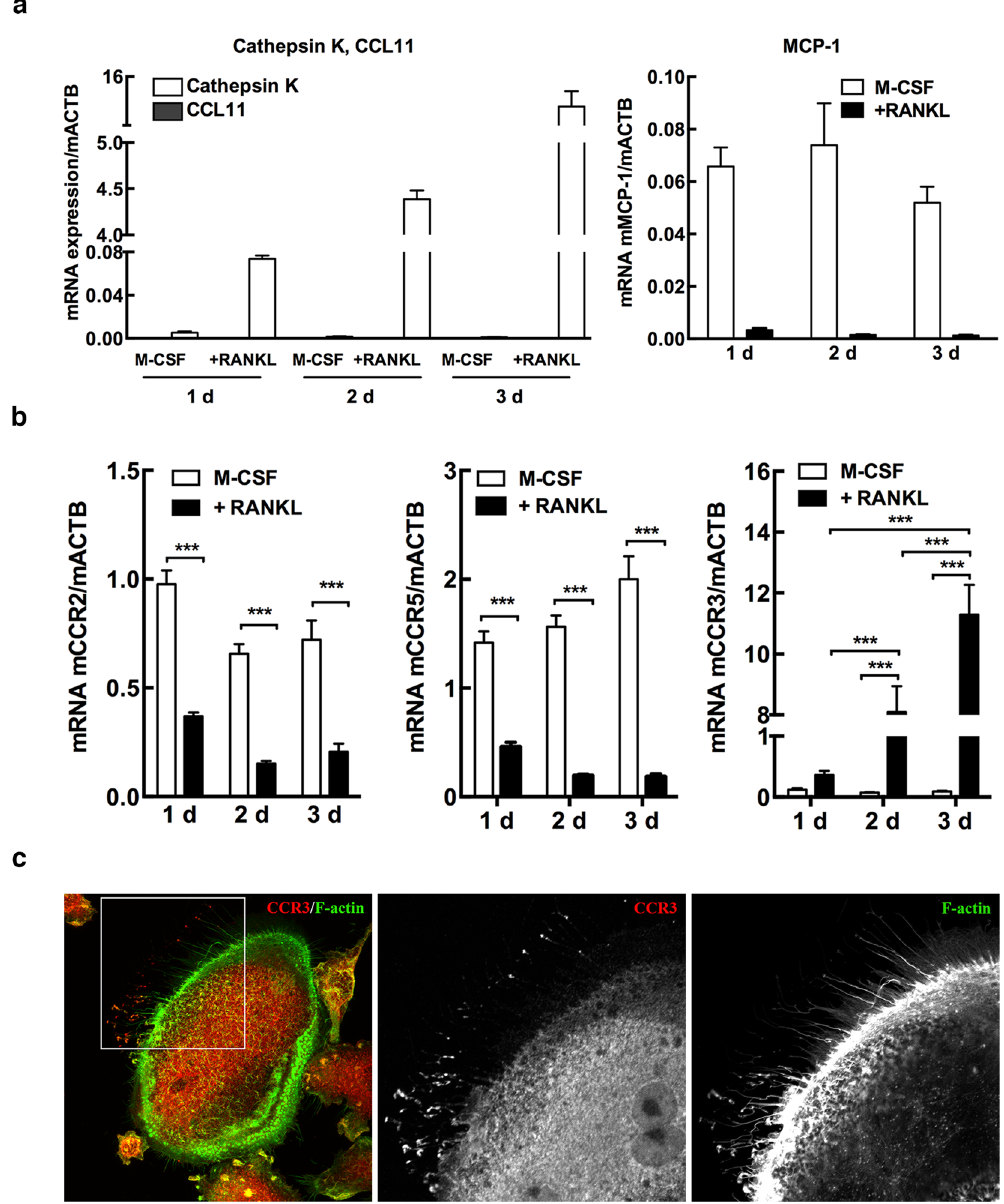
Figure 3. Osteoclasts do not express CCL11 but CCR3 mRNA and protein. ( a ) mRNA of CCL11 and the osteoclast associated enzyme Cathepsin K (left panel) and MCP-1 (right panel) analysed in BMM cultures stimulated with M-CSF alone or in presence of RANKL for 1, 2 and 3 days. ( b ) CCR2, CCR5 and CCR3 mRNA expression during RANKL-stimulated osteoclast differentiation. Data are expressed as means ± SEM. ( c ) Representative immunofluorescence staining of osteoclast culture (day 3) with CCR3 antibody in combination with F-actin to visualize actin